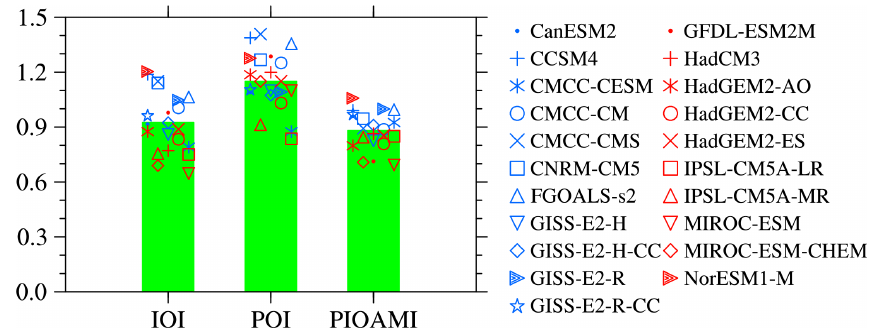
Figure 11. Ratios of standard deviation of the autumn IOI, POI and PIOAMI in each model to those in the HadISST dataset. Green bar represents the MME of the corresponding index.